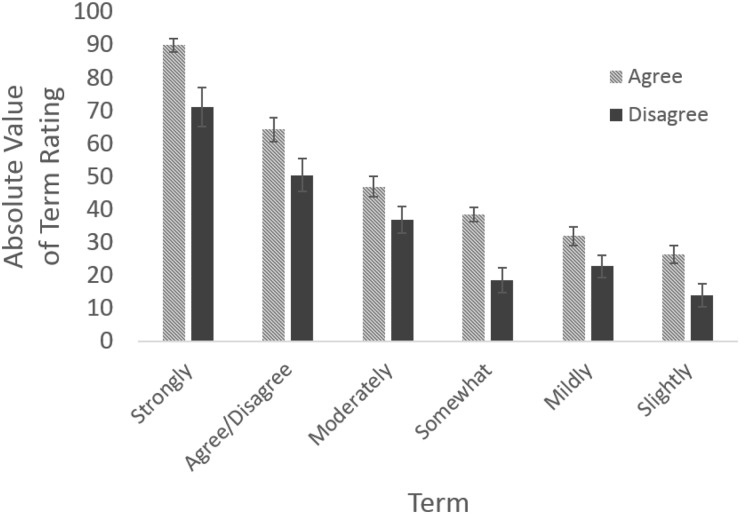
Likert term ratings (depicted here as the absolute distance from 0).Standard Error bars are illustrated.